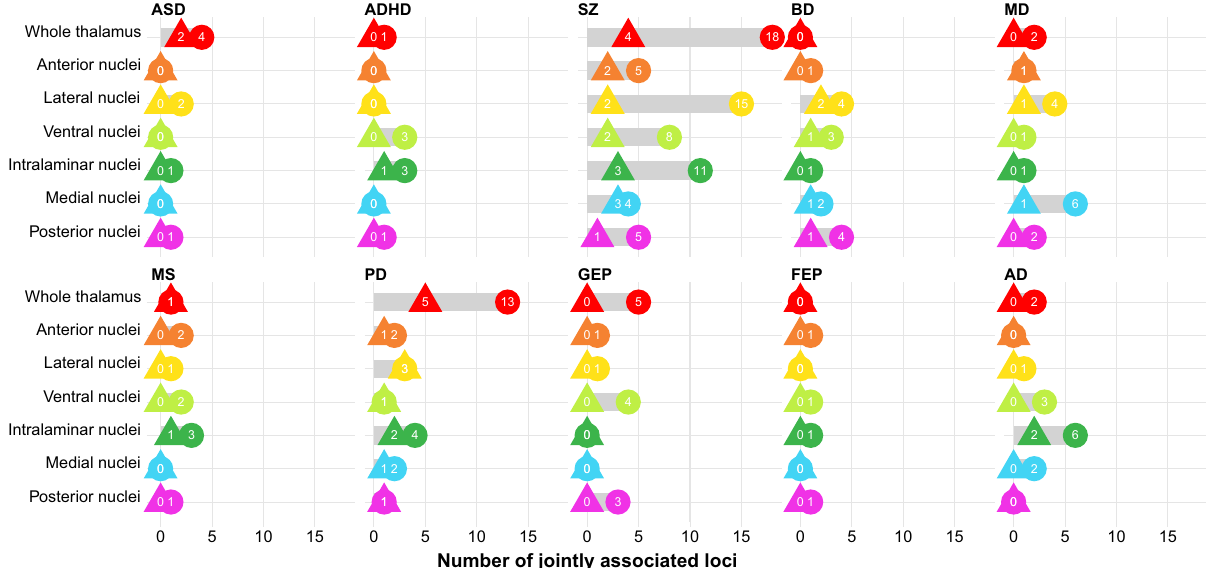
Fig. 5 Genetic loci shared between thalamic volumes and ten brain disorders. Conjunctional FDR analysis detected shared genetic loci across thalamic volumes and the ten disorders. The fi gure shows results with FDR thresholds of both 0.05 (circles) and 0.01 (triangles). We found the largest number of overlapping loci for SCZ (66), PD (26), and BD (15), when applying a conjunctional FDR threshold of 0.05. For ASD, ADHD, MD, MS, GEP, FEP, and MS, there were 8, 8, 17, 10, 14, 4, and 14 genetic loci jointly associated with thalamic volumes and disorders when using a threshold of 0.05, respectively. When using a conjunctional FDR threshold of 0.01, there were overlapping loci associated with thalamic volumes and SCZ (17), PD (14), BD (5), ASD (2), ADHD (1), MDD (3), MS (2), and AD (2), and no shared locus for GEP or FEP. AD, Alzheimer ’ s disease; ADHD, attention-de fi cit hyperactivity disorder; ASD, autism spectrum disorder; BD, bipolar disorder; FDR, false discovery rate; FEP, focal epilepsy; GEP, generalized epilepsy; MD, major depression; MS, multiple sclerosis; PD, Parkinson ’ s disease; SCZ,